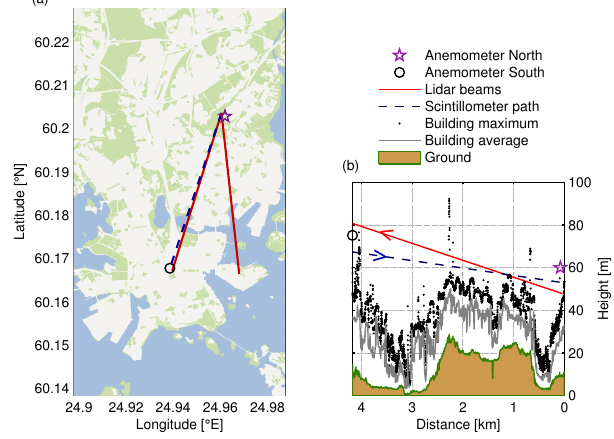
Figure 1. (a) Experimental setup with the locations of the instru- ments in Helsinki indicated, including Doppler lidarbeam azimuths of 174 and 196 ◦ ; shading is buildings/roads (white), grass/trees (green), and water (blue) (land cover data source: HSY, SeutuCD); the city centre is roughly the lower half of the map area. (b) A cross section (height ma.s.l.) of the scintillometer beam and lidar 196 ◦ beam; average building height and maximum building height are with respect to ± 250m laterally of the 196 ◦ beam (building height data source available at https://sui.csc.fi/applications/paituli/